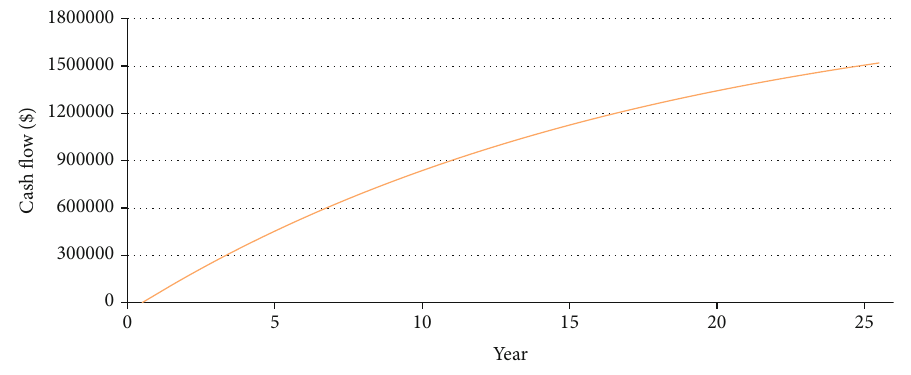
Figure 28: Cumulative cash fl ows over project lifetime